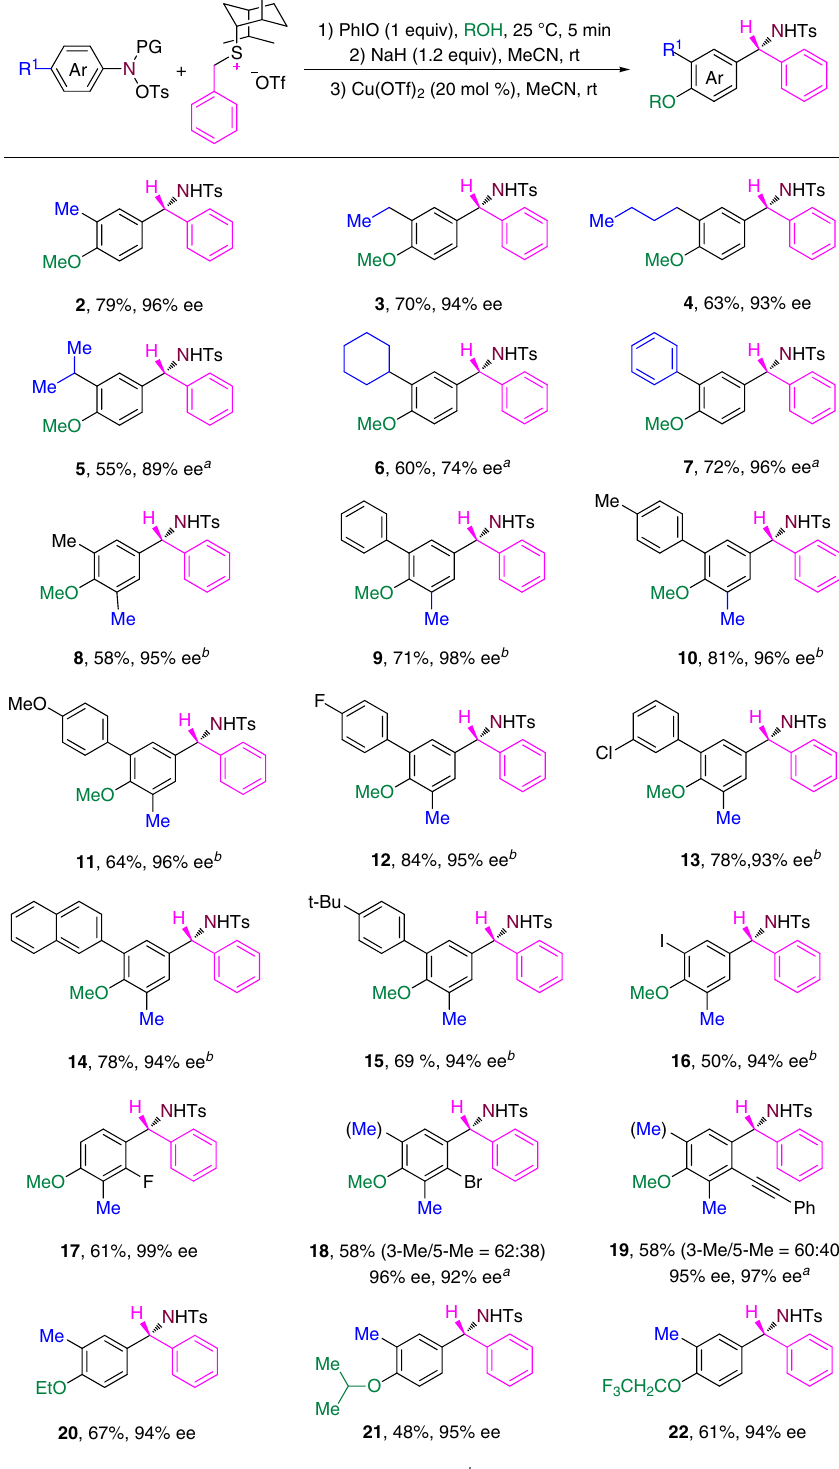
substituent position in benzyl sulfonium salts affected the reaction yield and enantioselectivity. For example, the 2-methoxy substituted benzyl sulfonium salt gave compound 26 in 91% yield with 96% ee, and the 4-methoxy substituted salt gave compound 28 in 58% yield with 92% ee. The reaction of a sulfonium salt bearing two meta-tert-